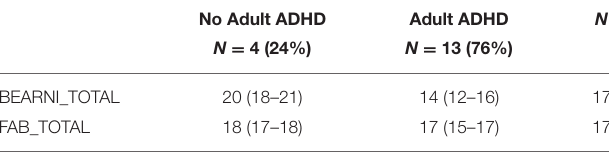
TABLE 3 | Neurocognitive measures as a function of adult